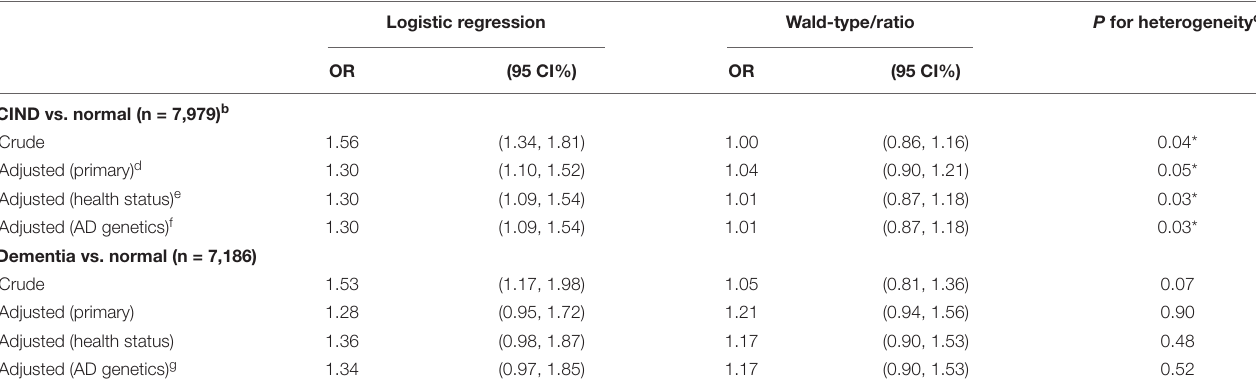
TABLE 4 | Associations between history of Type 2 diabetes mellitus and cognitive status, Health and Retirement Study, Wave 2010, European ancestry sample ( n = 8,433) a . Logistic regression Wald-type/ratio P for heterogeneity c OR (95